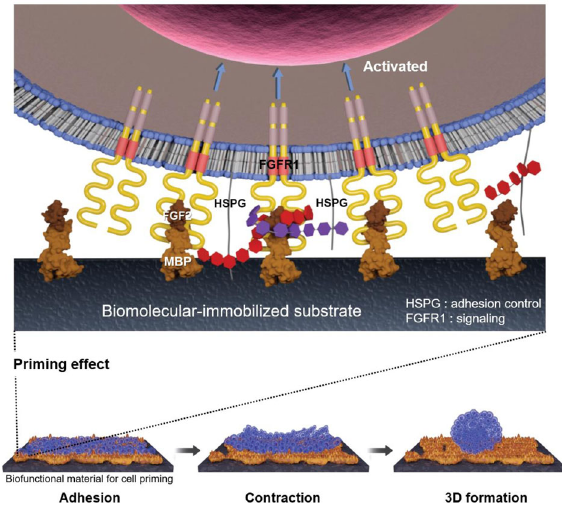
Fig. 1 Schematic illustration of MBP-FGF2 action on 3D formation and priming of hASCs. The MBP-FGF2 protein was immobilized on polystyrene plates. This biologically modi fi ed substrate could trigger an intracellular signaling pathway through binding with the membrane receptor, FGFR1. It also contributed to forming cellular spheroids by adhering to HSPG to control cell-matrix adhesion Fig. 1, a biologically modi fi ed surface plays multiple roles in enhancing cell function through cell membrane receptor signaling and forms cellular spheroids through control of the cell-matrix